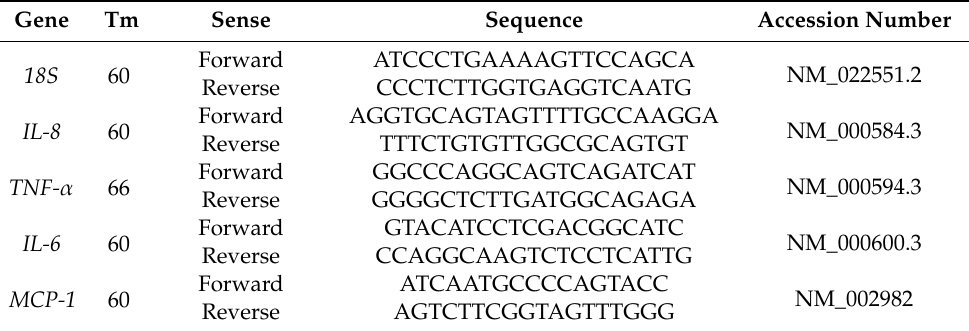
Table 1. Primer used for RT-qPCR